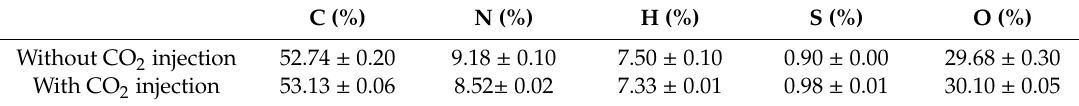
Table 4. E ff ect of CO 2 injections on the elemental composition of the biomass. C (%) N (%) H (%) S (%) O (%) Without CO 2